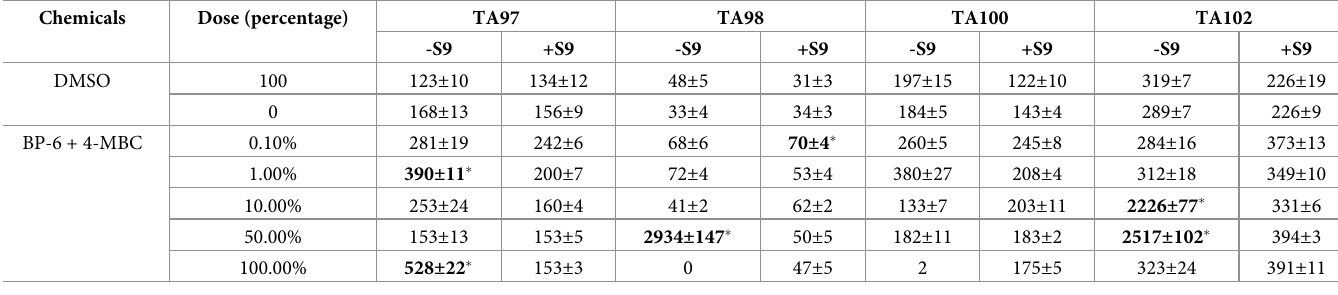
detected both in the two systems. For the TA100 strain, no mutagenicity was detected at each mixed ratio with and without S9. In conclusion, the mixture of BP-6 and 4-MBC caused posi- tive mutagenicity on TA97, TA98, and TA102 strains in the absence of S9. The highest ratio of the mixture caused inhabitation effects on TA98 and TA100 strain without S9. For the TA97 strain (Table 5 and Fig 5), each dose ratio of the mixture showed a positive effect without S9. For the TA98 and TA100 strain, the mixture caused a positive effect only at one ratio without S9 (1% for TA98 strain and 0.1% for TA100 strain). Especially, the MR value decreased sharply as the dose ratio increased. For TA102 strain, the mixture caused strong mutagenicity at 50% and 100% without S9 (MR value was up to10). Generally speaking, the mixture of BP-6, BP-8, and 4-MBC caused positive mutagenicity to all tested strains without Table 4. Reverse mutation colonies of four S . typhimurium strains exposed to mixtures of BP-6 and 4-MBC with and without S9. Chemicals Dose (percentage)